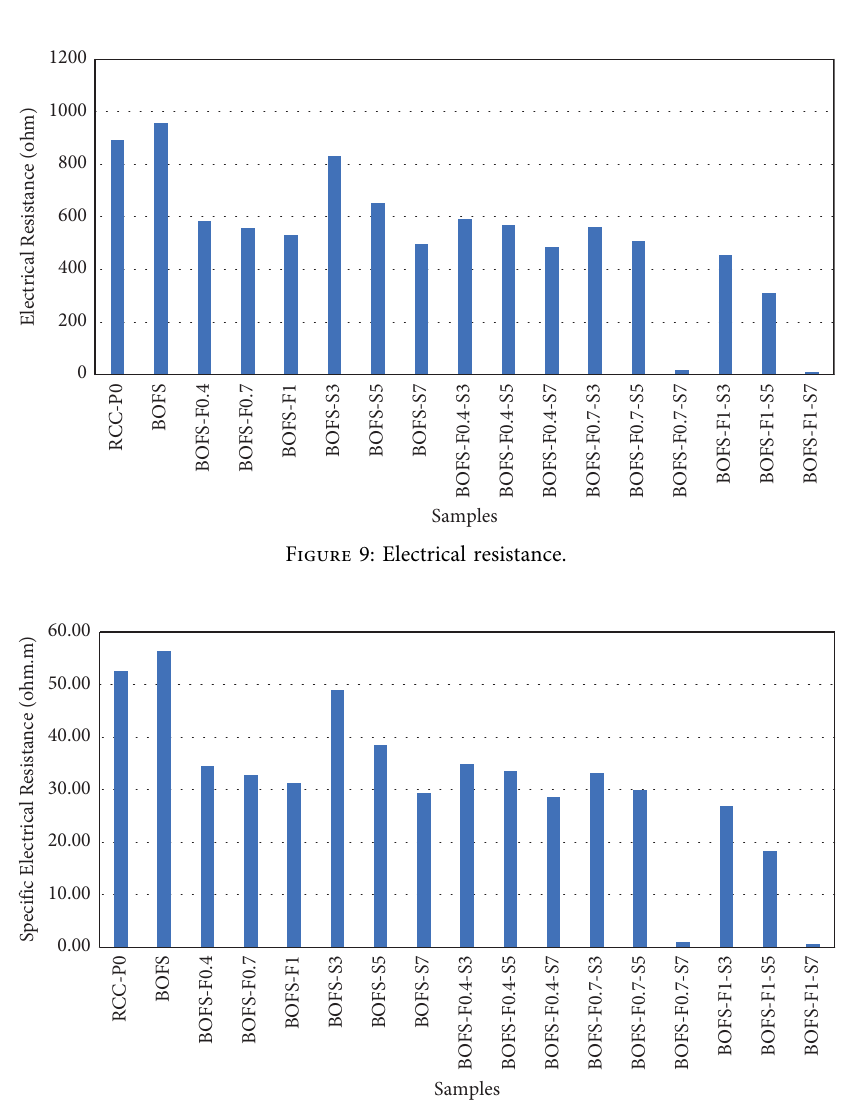
Figure 10: Specifc electrical